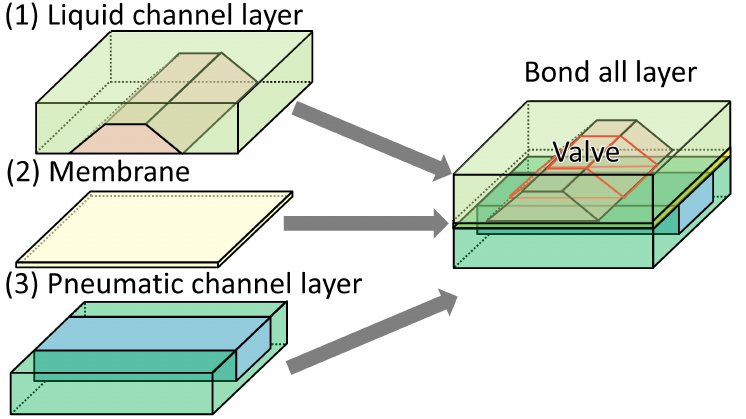
Figure 5. Schematic illustration of the layers of the microvalve with the trapezoid-shaped cross-section.